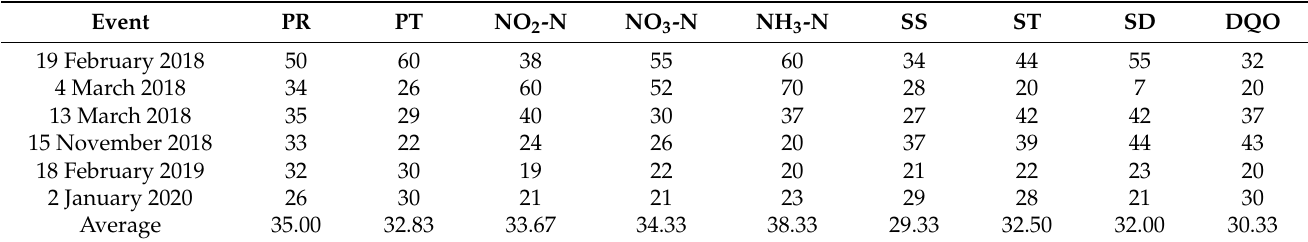
Table 4. Percentage of the mass of pollutants discharged in the first 30% of the volume of each analyzed event. Event PR